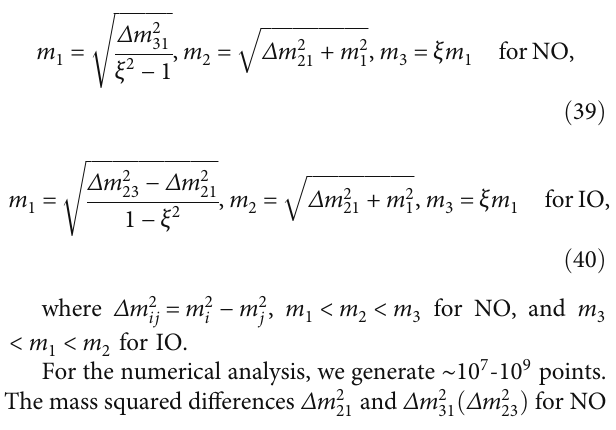
ν with TM 2 mixing at 3